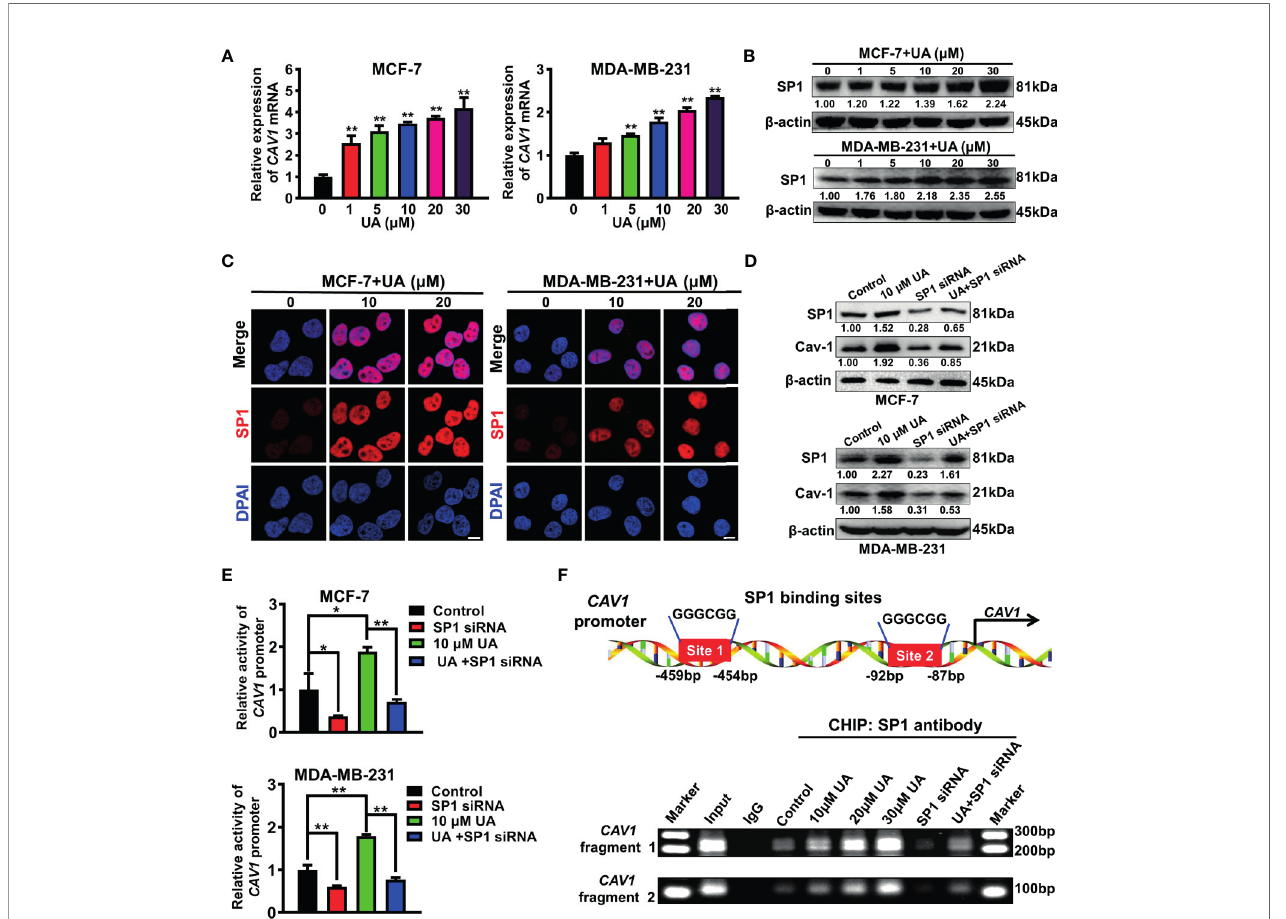
FIGURE 5 | Ursolic acid impairs the glycolytic metabolism of breast cancer cells by activating SP1/Cav-1 signaling. (A) MCF-7 and MDA-MB-231 cells were treated with 1~30 m M ursolic acid for 48 h QPCR assay was conducted to investigate the effect of ursolic acid on CAV1 mRNA expression in breast cancer cells. (B) The expression change of SP1 protein in MCF-7 and MDA-MB-231 cells after ursolic acid (1~30 m M) treatment for 48 h (C) MCF-7 and MDA-MB-231 cells were treated with 10~20 m M ursolic acid for 48 h Cell immuno fl uorescence assay was conducted to investigate the effect of ursolic acid on SP1 expression in breast cancer cells. Scale bar = 10 m m. (D) Breast cancer cells were transfected with SP1 speci fi c siRNAs or treated with 10 m M ursolic acid for 48 h The combinational effects of SP1 knockdown and ursolic acid treatment on SP1 and Cav-1 expression levels in breast cancer cells were detected by Western blotting assay. (E) Breast cancer cells were treated with 10 m M ursolic acid for 24 h or transfected with SP1 speci fi c siRNAs. The combinational effects of SP1 knockdown and ursolic acid treatment on CAV1 promoter activity in breast cancer cells were detected by the double luciferase reporter gene assay. (F) MCF-7 cells were transfected with SP1 speci fi c siRNAs or treated with 10~30 m M ursolic acid for 48 h CHIP-PCR assay was conducted to investigate the effects of ursolic acid treatment, SP1 knockdown or their combination on the binding of SP1 with CAV1 promoter region of breast cancer cells. N = 3. * p < 0.05. ** p <